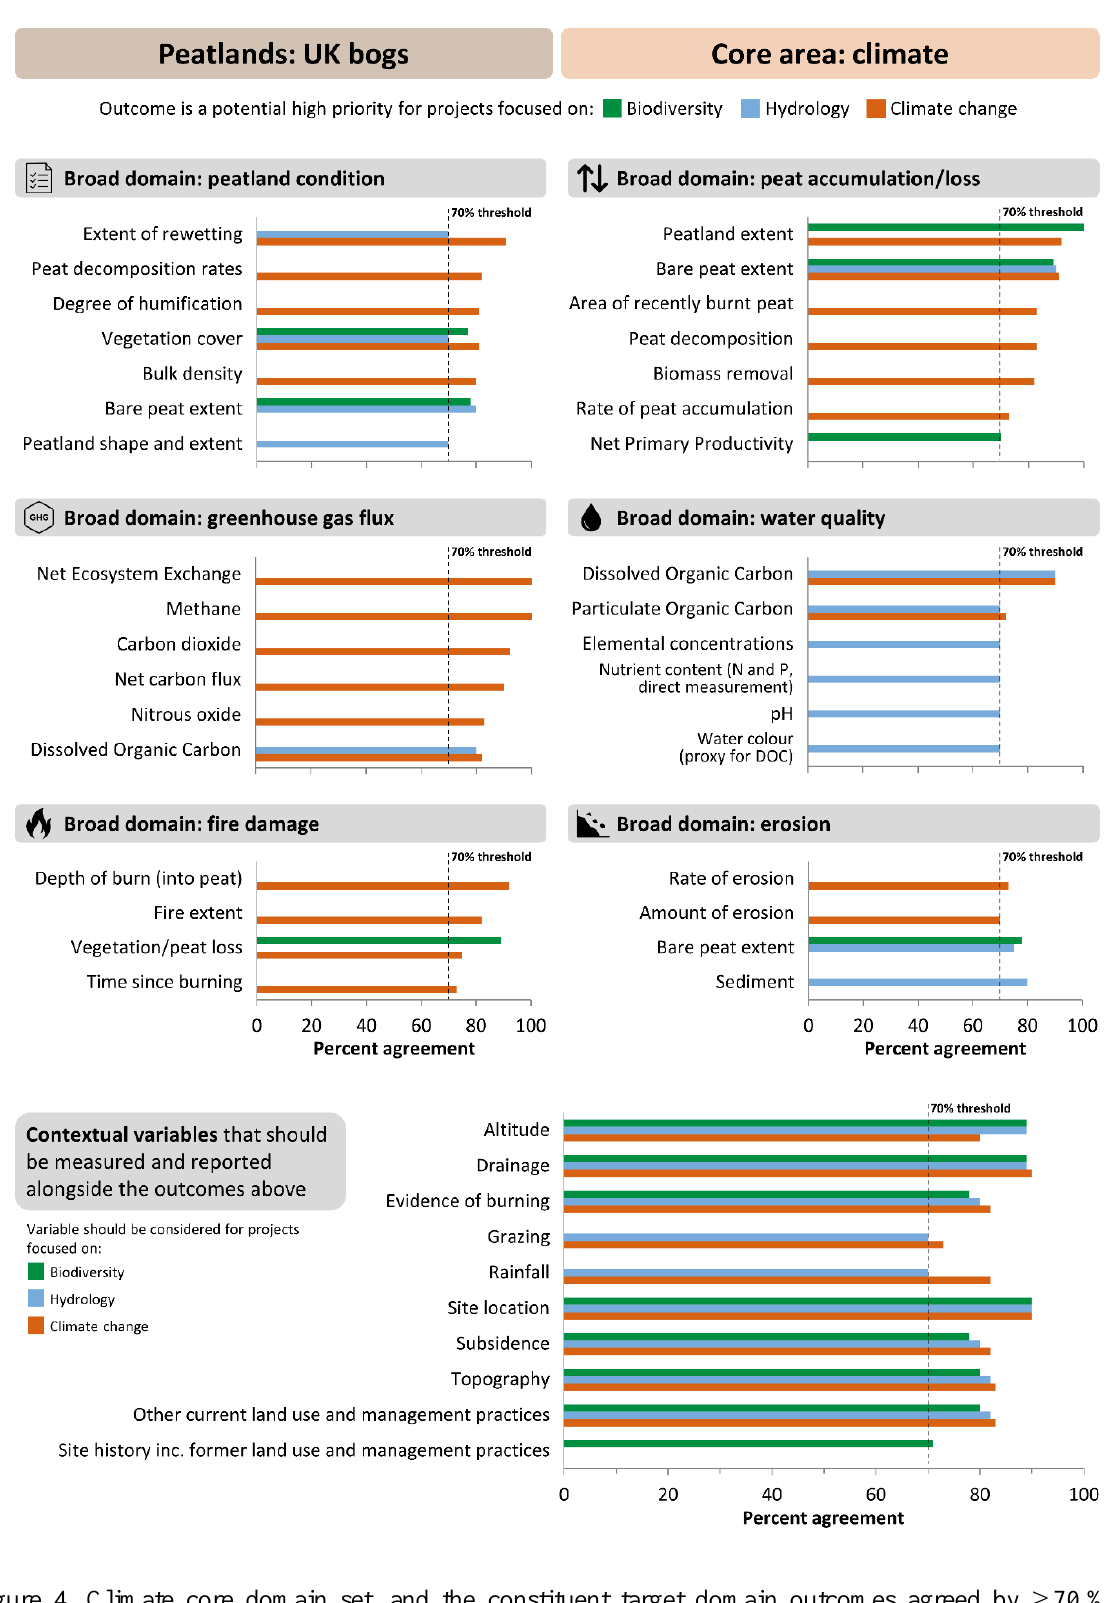
Figure 4. Climate core domain set, and the constituent target domain outcomes agreed by ≥ 70 % of respondents as potential high priorities for measurement in UK peatland research or monitoring, depending on the objective or focus of the research or restoration project (based on 12 expert responses). Scores < 70 % are not